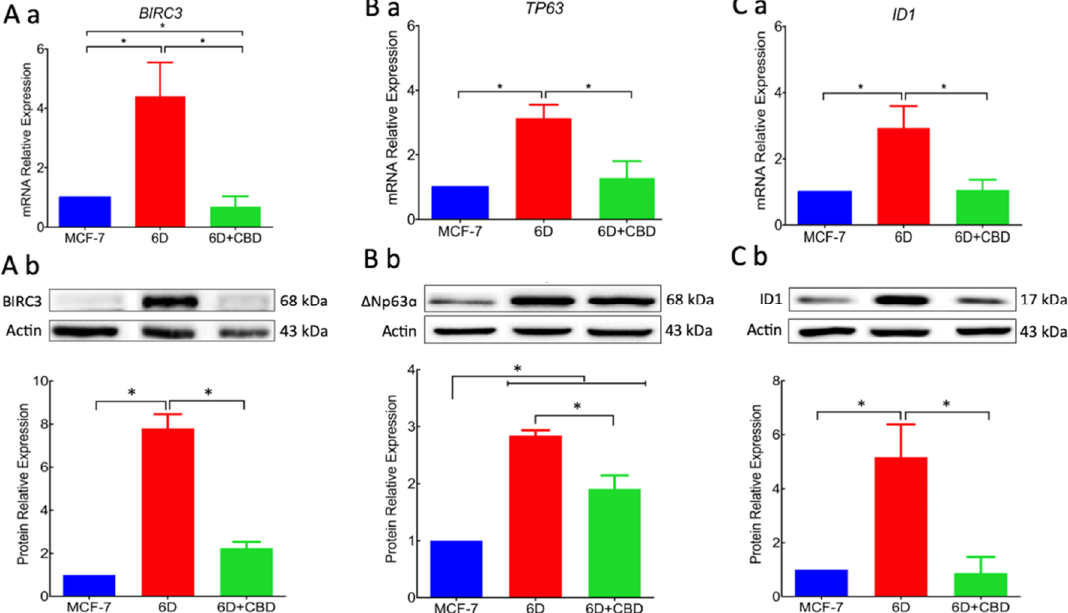
Figure 6. The CBD modified the overexpression of effector proteins downstream in the IL-1β-induced pathway. ( Aa ) mRNA relative expression levels of gene BIRC3 that codifies for the BIRC3 protein was determined in MCF-7cells and 6D cells treated or not treated with CBD. The data of mRNA expression in all the cases were normalized to the expression of gene RPLP0 . ( Ab ) Representative Western blot of BIRC3 in the three cell types mentioned above. Densitometric values corresponding to BIRC3 levels were normalized to actin and expressed relative to those in MCF-7 cells. ( Ba ) mRNA relative expression of the TP63 gene and the ∆NP63α isoform ( Bb ). ( Ca ) mRNA relative expression levels of gene ID1 and ID1 protein ( Cb ). Representative Western blot of ID1 levels in the cells. mRNA expression and Western blot results represent the average of three independent batches of cells (biological replicates, n = 3) ± SD. Asterisks indicate p < 0.05.